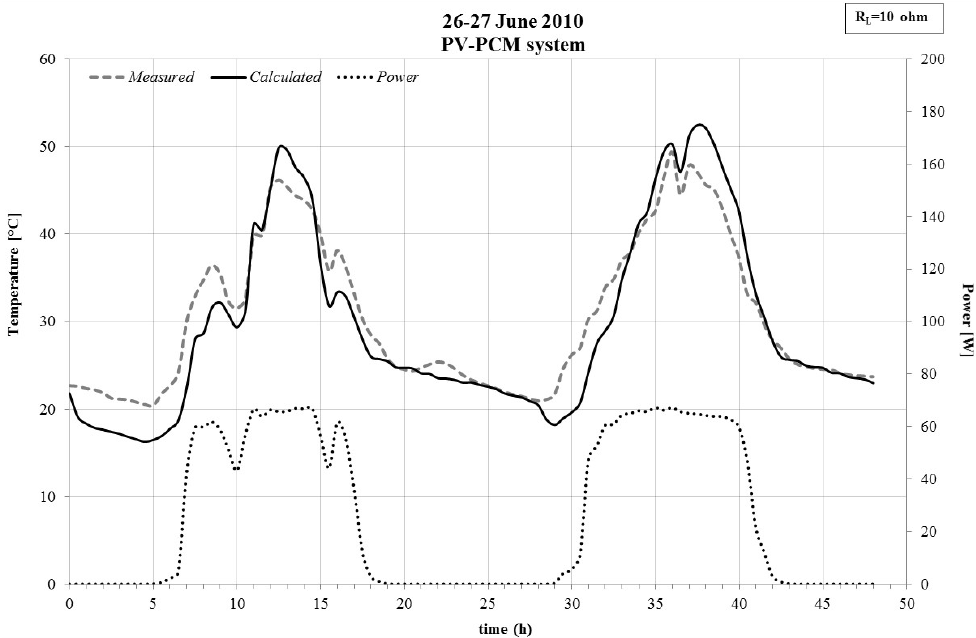
Figure 12. Temperature trend of the measured and simulated PV-PCM system together with measured power output, in Palermo, 26–27 June